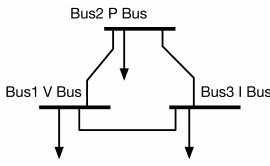
Figure 11. A simple power system.